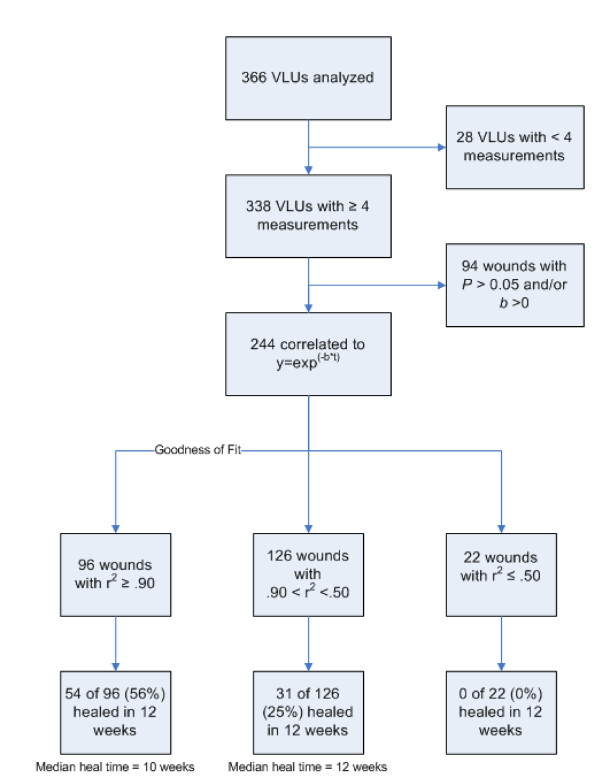
Flow chart of clinical and regression analysis results.